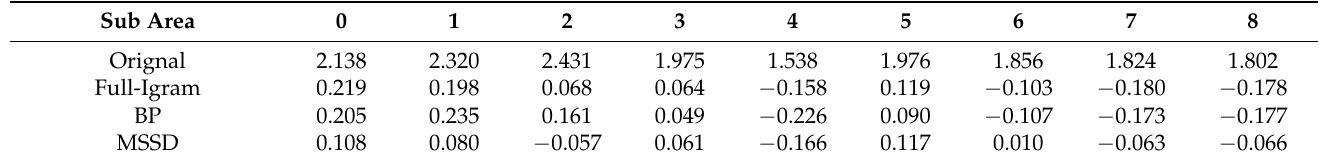
Table 4. Correlation coe ffi cients of 9 sub-regions after model-removed.